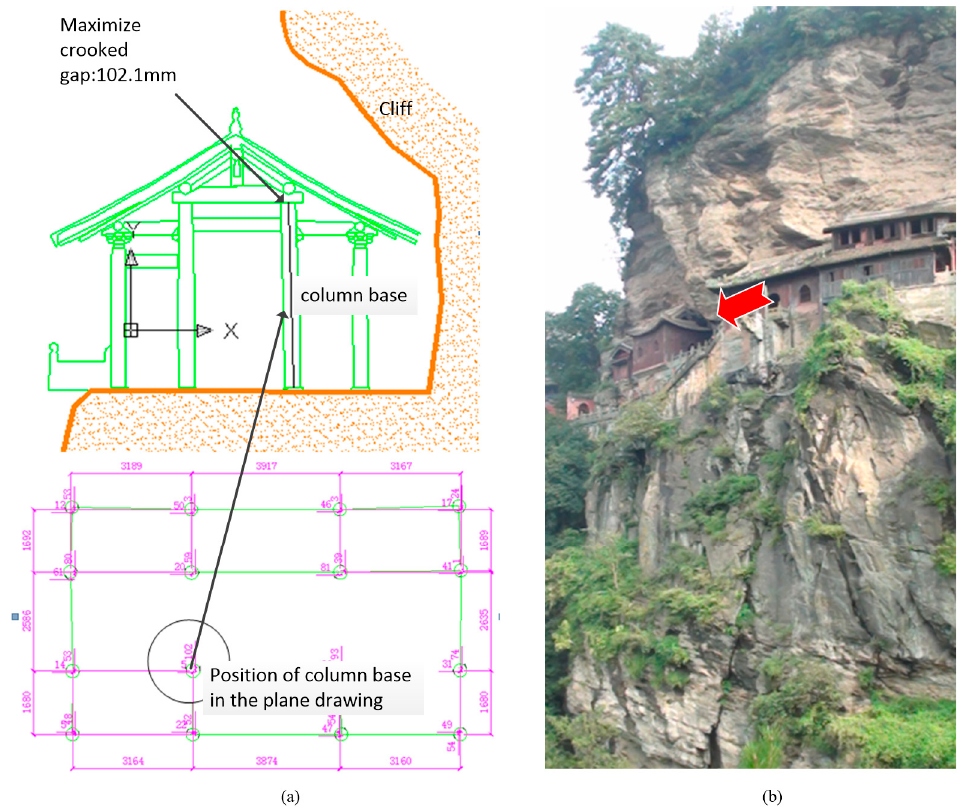
Figure 18. Deformation analysis of the column base. ( a ) Crooked column on the section drawing; ( b ) crooked direction of Liangyi Temple.